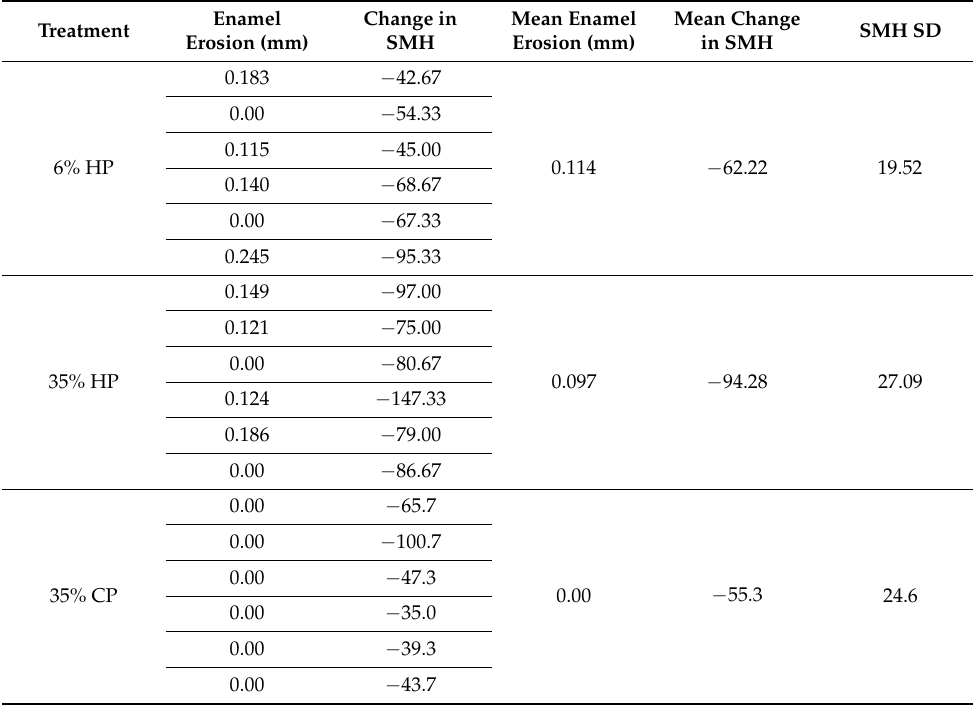
Table 1. Post-treatment changes in enamel erosion and surface microhardness (SMH).